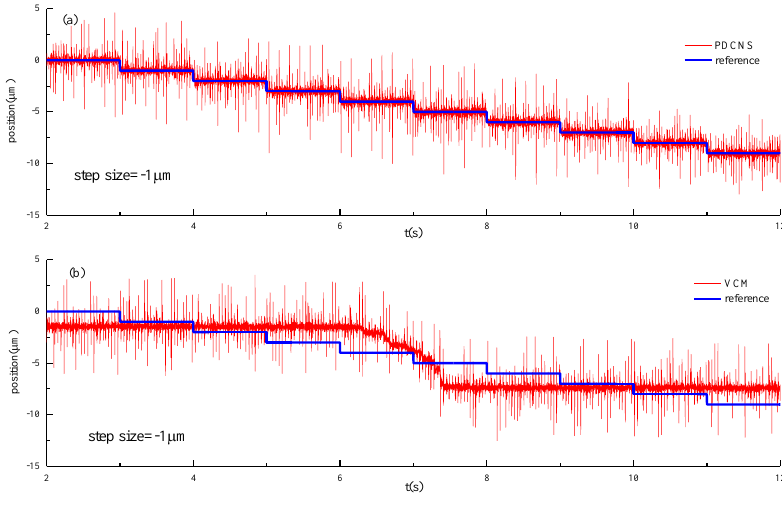
Figure 15. Multistep (step size of −1 μm) response of ( a ) PDCNS and ( b ) VCM. (4) Positioning with nm-level steps. Finally, the nanometer-level positioning capability of the proposed PDCNS (with DSCC) is investigated by two consecutive-step reference signals with step sizes of ± 50 nm. In this subsection, to improve the signal-to-noise ratio, the laser displacement sensor is configured to have a measurement range of − 10 µ m to 10 µ m (corresponding to an output voltage of − 10 V to 10 V). A 50 nm height staircase trajectory response is clearly obtained in Figure 16a. Moreover, a continuous stepping movement with amplitude of − 50 nm can be observed in Figure 16b. Therefore, the closed-loop-positioning resolution of the proposed PDCNS is better than 50